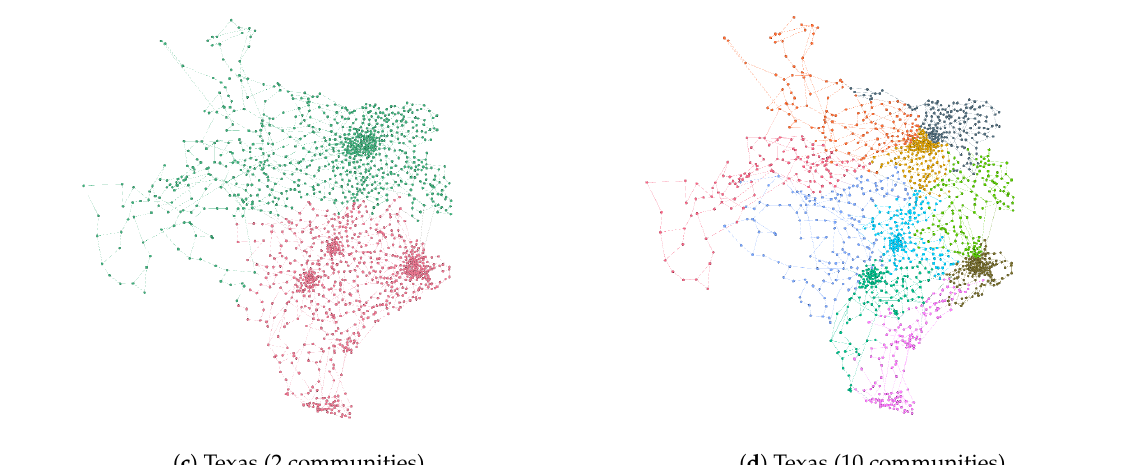
Figure 5. Communities detected in the networks representing the power grids of the Iberian Peninsula and Texas considering 2 and 10